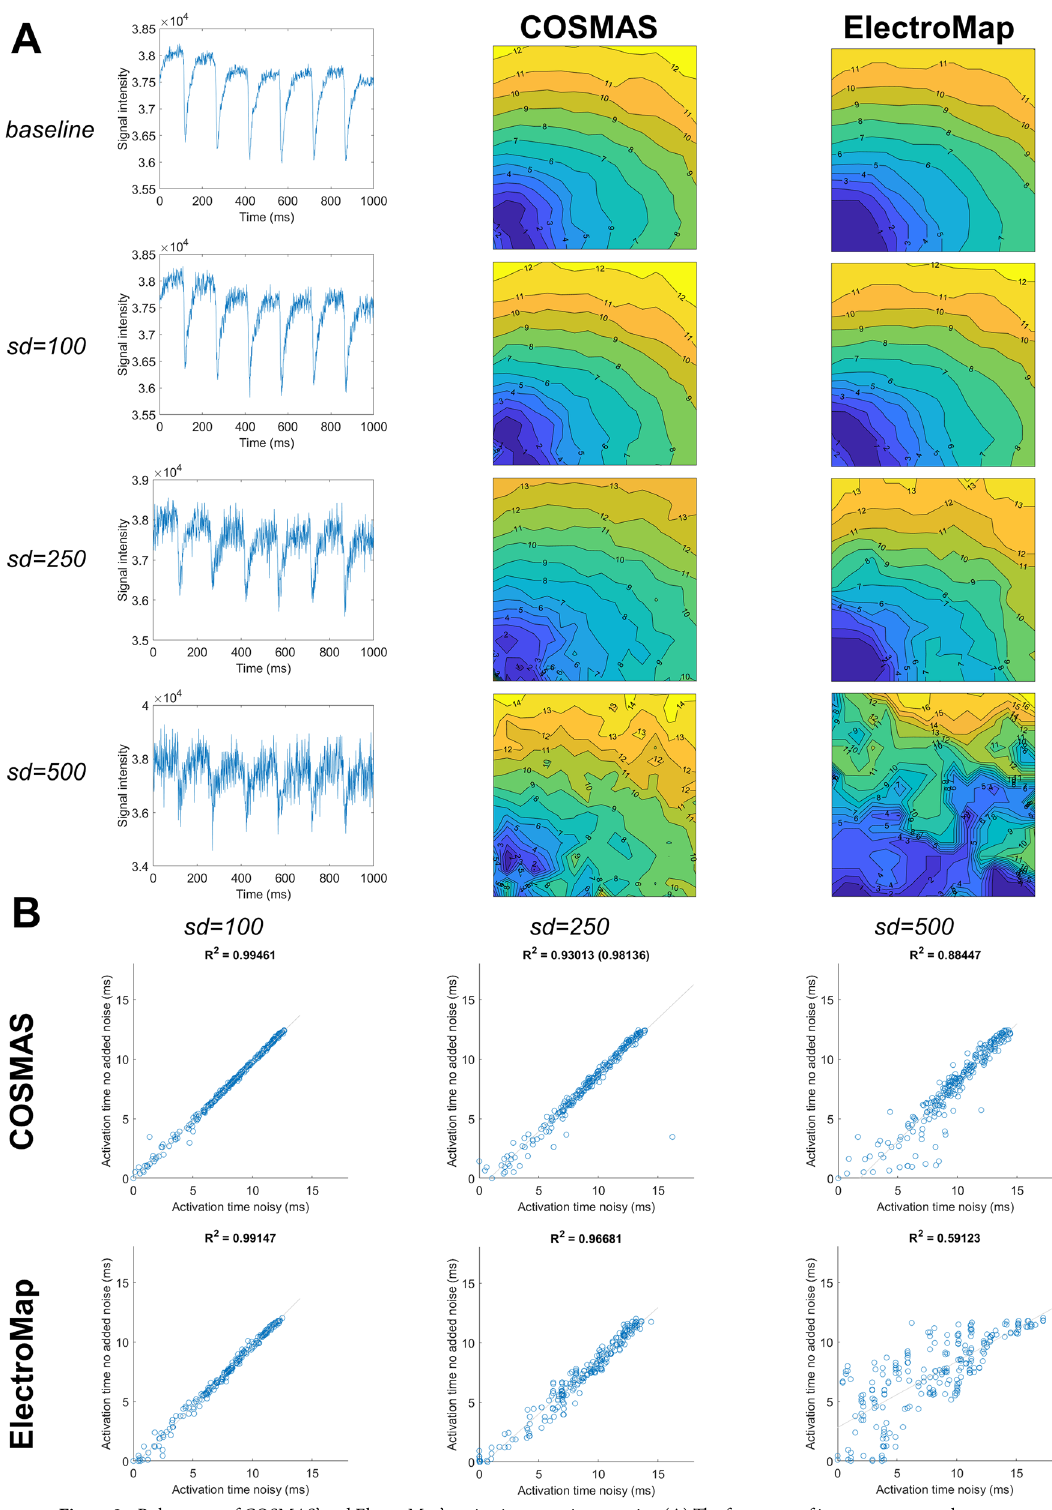
Figure 9. Robustness of COSMAS’ and ElectroMap’s activation mapping to noise. ( A ) The four rows of images correspond to a baseline recording, and then the same recording with three levels of added noise (Gaussian noise with standard deviation of 100, 250, and 500). The first column shows a sample pixel trace from the center of the field of view, the second column gives the activation maps produced by COSMAS, with the third column displaying activation maps produced by ElectroMap. ( B ) A measure of how the extracted activation pattern changes with added noise. In the three columns is shown, for both tools, the correlation of activation times in the noisy recordings (x-axis) versus the activation times in control recording (y-axis). Tight correlation means that there is little change in activation detection with the added noise. Above the correlation plots is given the R 2 statistic, corresponding to goodness-of-fit. In COSMAS, noise sd = 250, the R 2 value in parentheses gives the statistic value after removal of one outlier point which perturbs the statistic markedly. Parameters of COSMAS and ElectroMap were matched whenever possible (see Methods for details). The original data with no added noise come from Langendorff-perfused rat hearts paced at 150 ms basic cycle